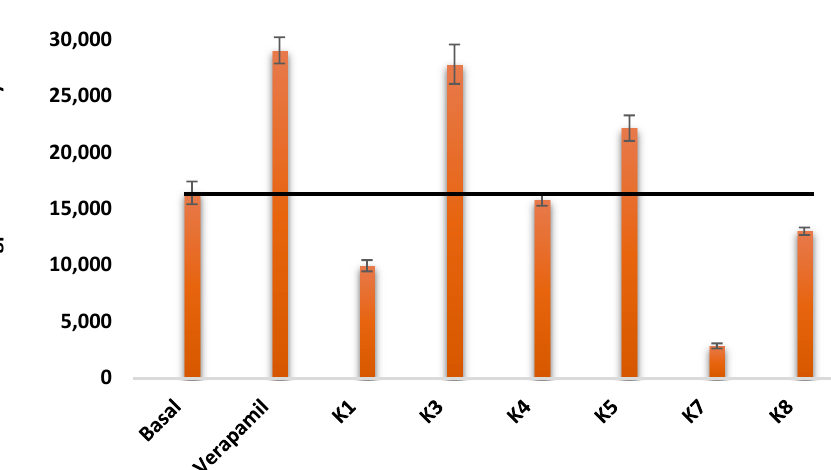
Figure 3. Relative ABCB1 (P-gp) ATPase inhibition activity of selected ketone-selenoesters. The effects are presented as the relative ATPase activity. The decrease in luminescence of untreated samples compared to samples treated with sodium-vanadate represents basal P-gp ATPase activity. The decrease in luminescence of verapamil-treated samples represents verapamil-stimulated P-gp ATPase activity. The lower the relative ATPase activity, the better the inhibitor. Results are calculated as the means ± SD from experiments performed in triplicate. The level of basal activity is presented as a black line.